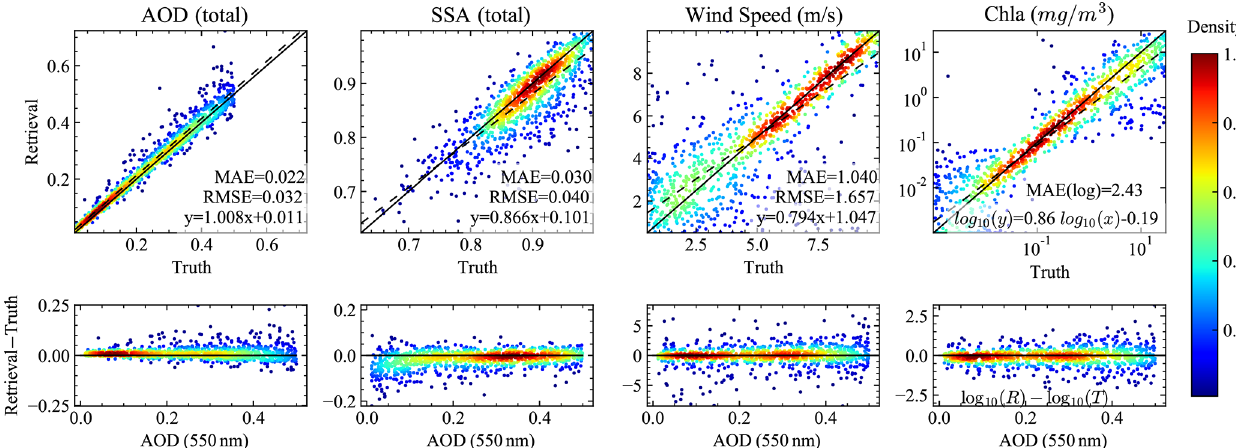
Figure 7. The comparisons of the retrieved and truth values for total AOD (550nm), SSA (550nm), wind speed, and Chl a are shown in the top panels. The dashed line indicates the linear regression fitting with y = βx + α , where β is the slope and α is the intercept. The lower panels show the difference between the retrieved and truth values of the corresponding upper panel parameters as a function of the total AOD at 550nm.